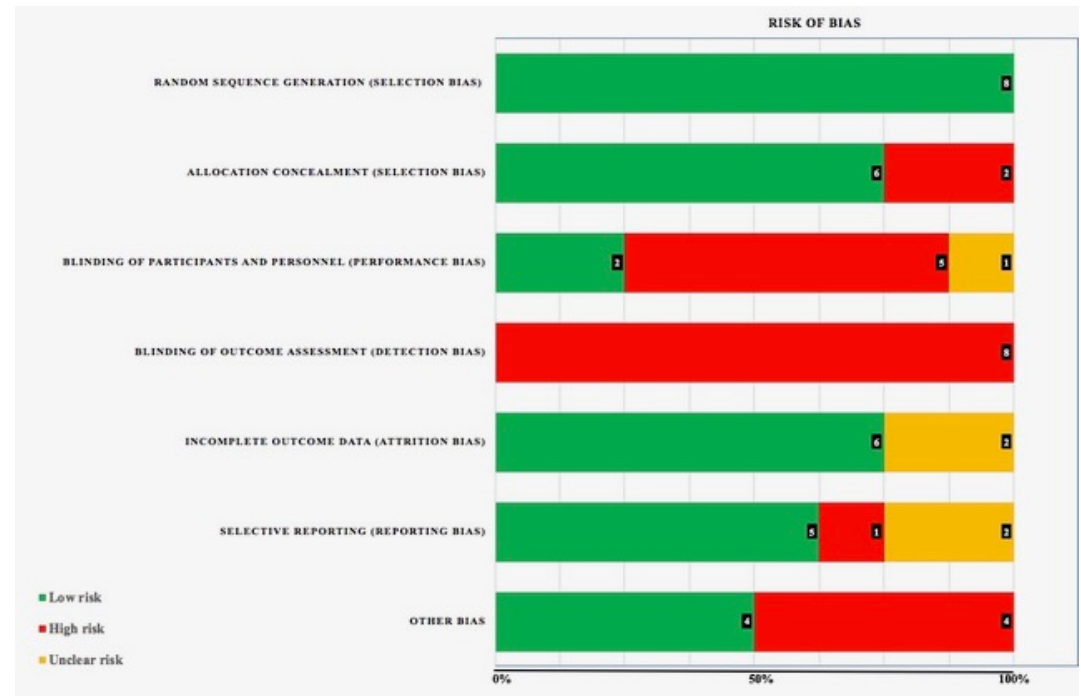
Figure 2. Risk of bias.